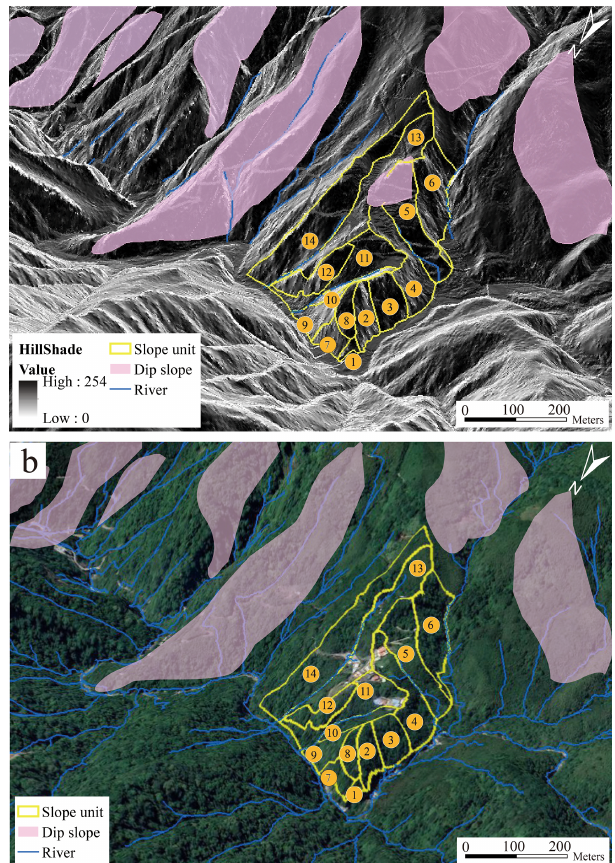
Figure 4. (a) Distributions of 14 slope units around the Neikuihui tribe (background: modified from 2020 data from the Department of Lands, Ministry of the Interior, for research purposes only; aerial: ESRI ArcGIS 10.4); (b) household distribution map (background: modified from © Google Earth 2021; aerial: ESRI ArcGIS